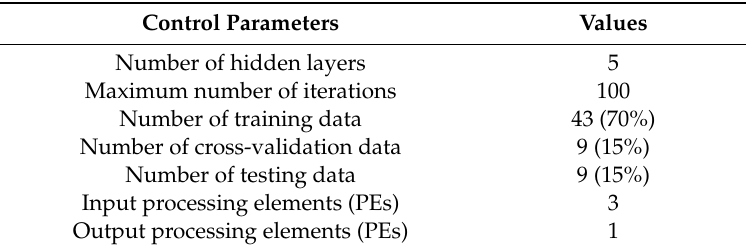
Table 8. Details of the developed model of